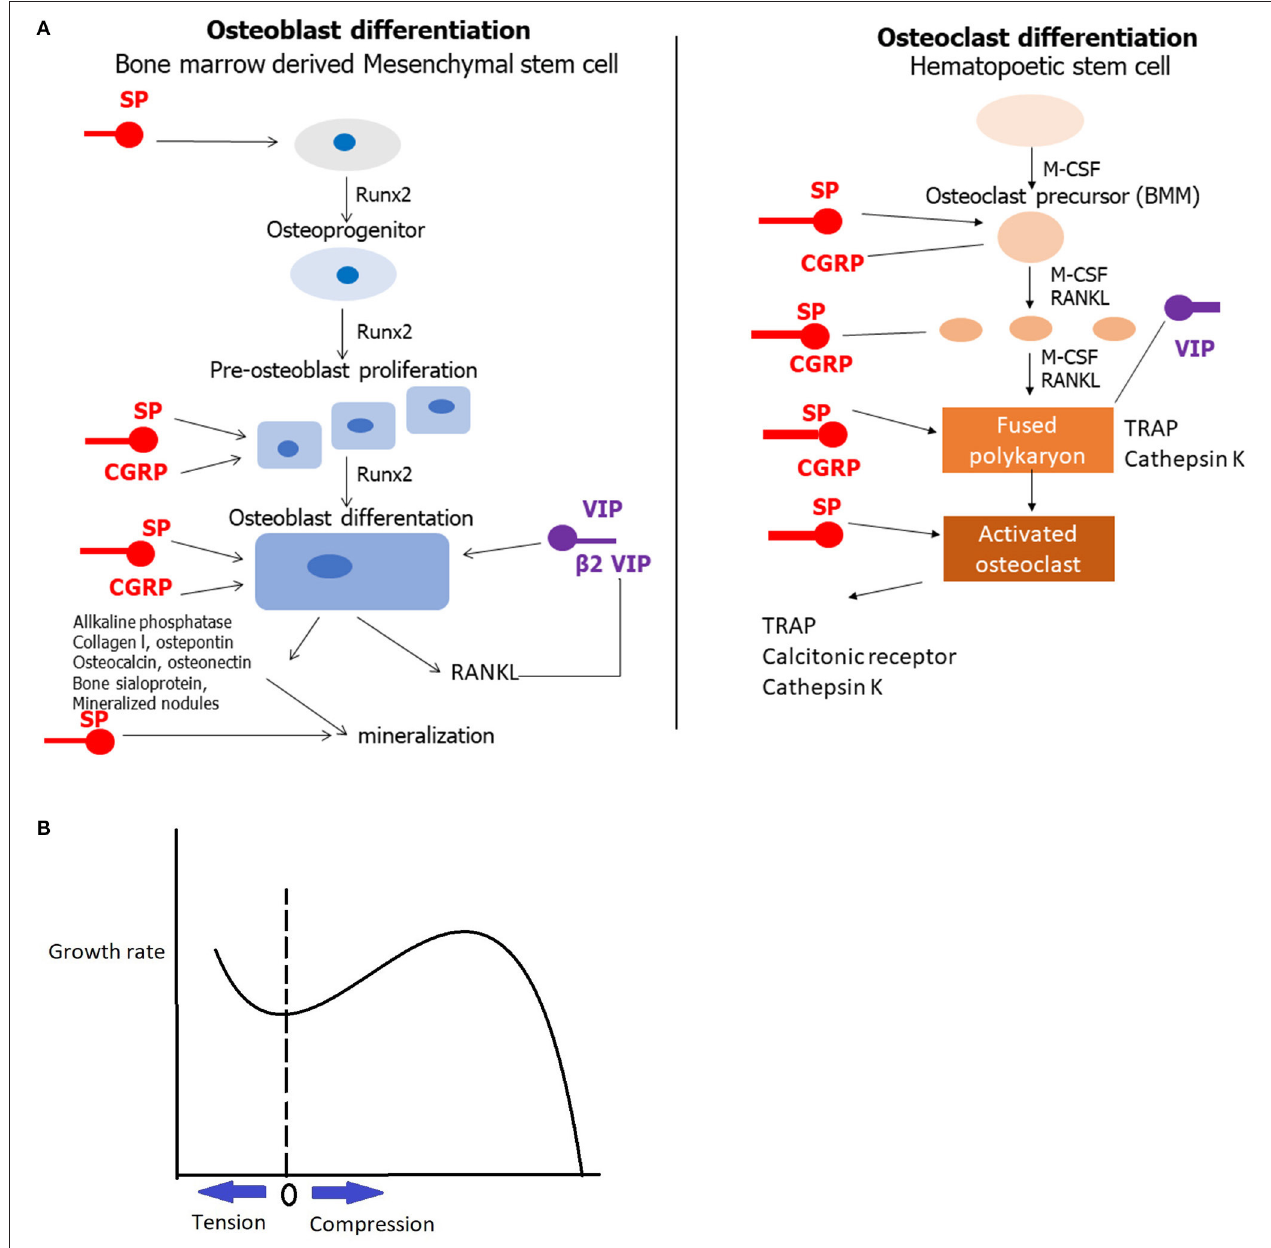
FIGURE 1 | (A) The role of CGRP, VIP and SP in bone metabolism. A line with an arrow at the end shows stimulation, whereas a line without the arrow indicates inhibition. (B) The Frost’s graph depicting that compression and tension till a certain level induce bone growth. The horizontal axis depicts load in the growth plate from maximum tension to the left, through 0 to compression in the right. The vertical axis depicts the growth